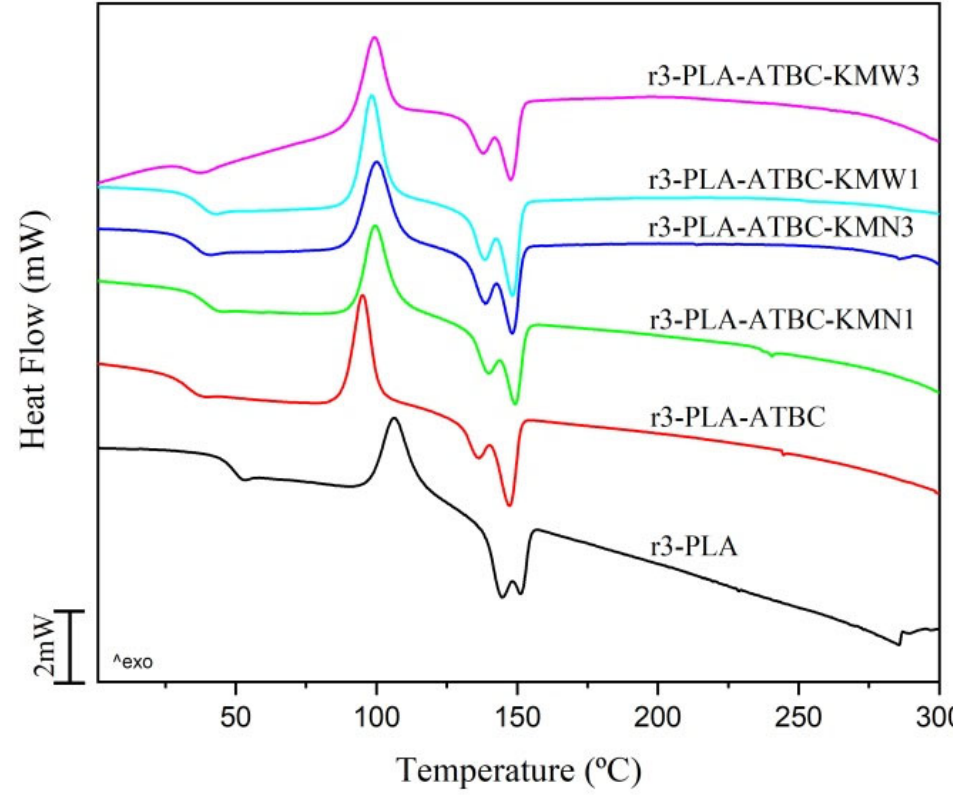
Figure 4. DSC second heating scan of 3r-PLA-ATBC-based films.